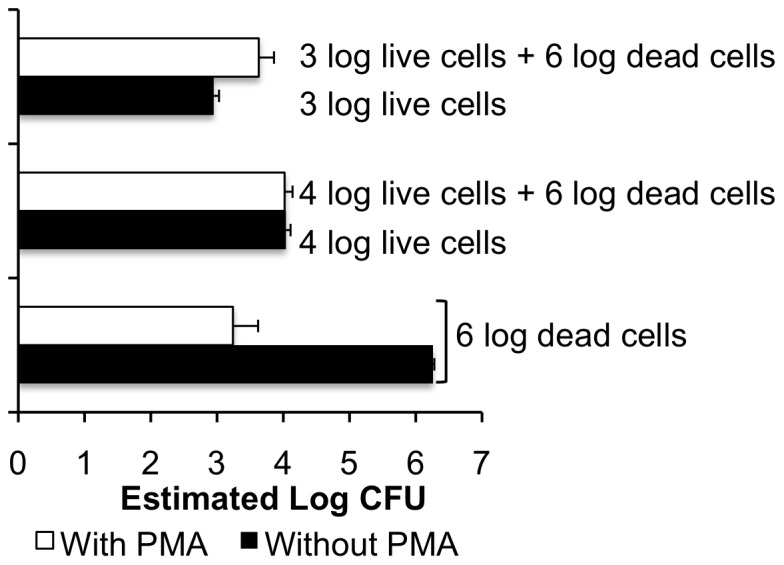
Interference of dead cells in the enumeration of live E. coli O157:H7 by PMA real-time PCR.Cell amounts were quantified by real-time PCR (total; black bars) or PMA real-time PCR (viable; open bars) in mixtures of 103 or 104 live cells mixed with 106 isopropanol-inactivated dead cells. Samples were treated with 40 µM PMA for 30 min. Estimates of E coli O157:H7 cell amounts were based on comparisons to standard curves constructed using E. coli O157:H7 ATCC 700728 genomic DNA. Each bar represents the mean ± stdev for three independent replicates.